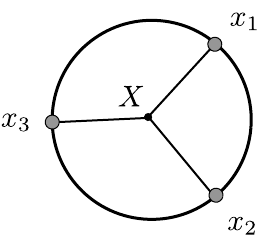
Figure 2 . Three-point Witten